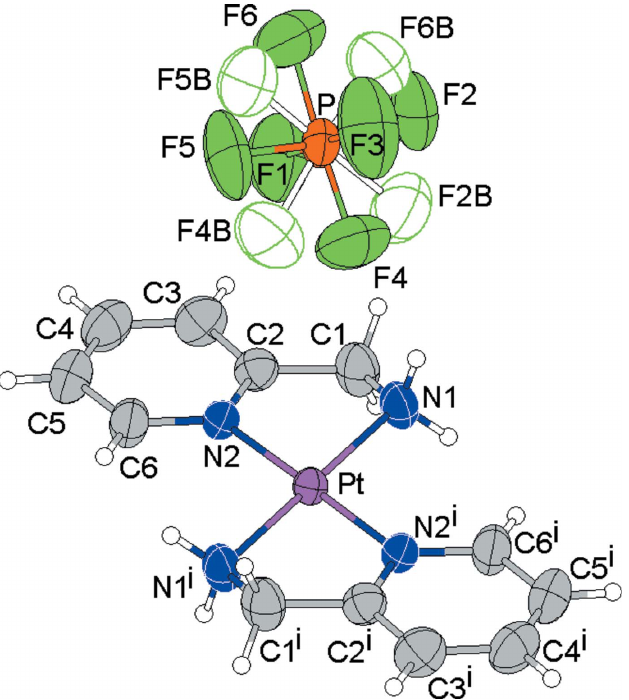
Figure 1 The structures of the molecular components of the title salt, showing the atomic numbering scheme. Displacement ellipsoids are drawn at the 50% probability level for non-H atoms. The green hollow F ellipsoids and the black hollow lines between P and F atoms represent the minor disorder component of the PF 6 anion [symmetry code: (i) (cid:2) x , 1 (cid:2) y , 1 (cid:2) z